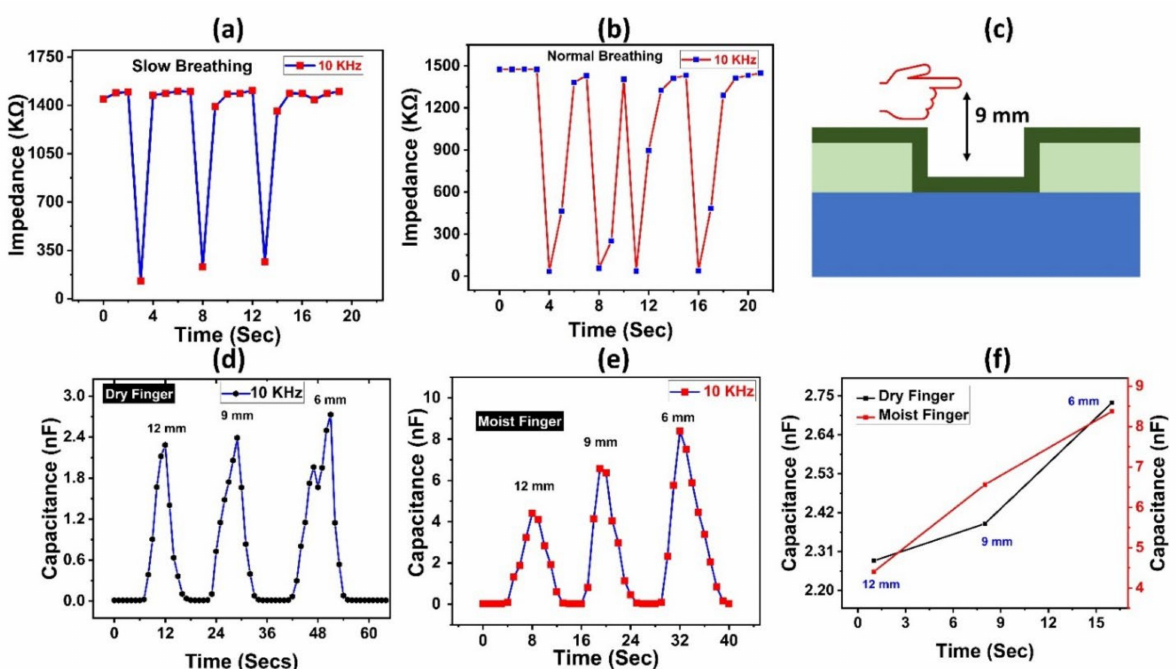
Figure 5. Impedance response to ( a ) human slow breathing and ( b ) human normal oral breathing. ( c ) Schematic diagram of oral breathing test of the humidity sensor. ( d ) Capacitance curve for the proximity test for the dry finger of the proposed sensor at fixed distances of 6 mm, 9 mm, and 12 mm. ( e ) Capacitance curve for the proximity test for the moist finger of the proposed sensor at fixed distances of 6 mm, 9 mm, and 12 mm. ( f ) Capacitance measurements of sensor at different proximities.